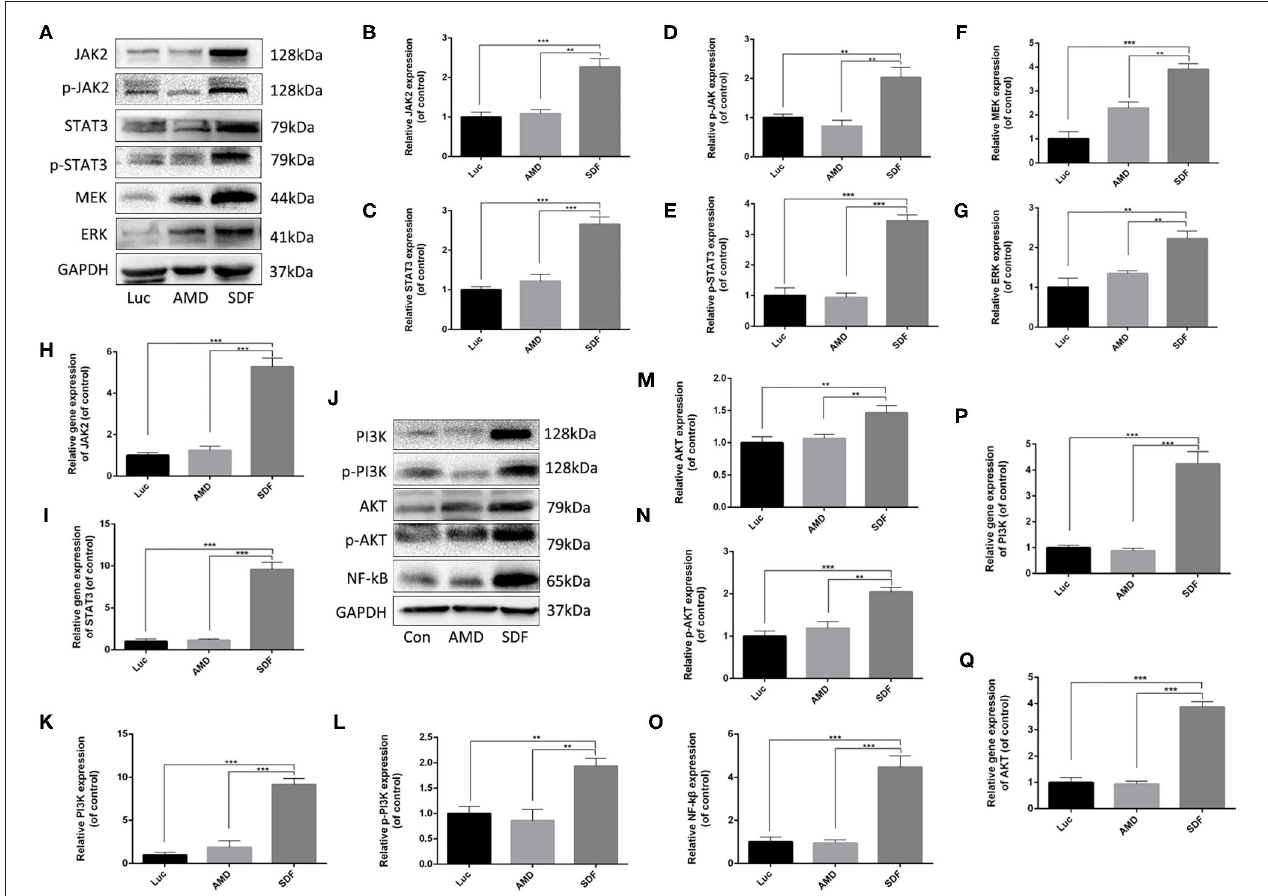
FIGURE 7 | SDF-1 α modRNA promoted cell proliferation and blocked apoptosis via activation of the JAK-STAT, ERK, and PI3K-AKT signaling pathways. (A–G) Representative western blots and quantification of JAK2, p-JAK2, STAT3, p-STAT3, MEK, and ERK proteins in fibroblasts after treatment with SDF-1 α modRNA. (H) The expression of JAK2 and (I) STAT3 genes was detected by qRT-PCR. (J–O) Representative western blots and quantification of PI3K, p-PI3K, AKT, p-AKT and NF-kB proteins in fibroblasts after treatment with SDF-1 α modRNA. (P) The expression of PI3K and (Q) AKT genes was detected by qRT-PCR. Data represent the mean ± SD ( n = 5). ** P = (0.01–0.05), *** P <